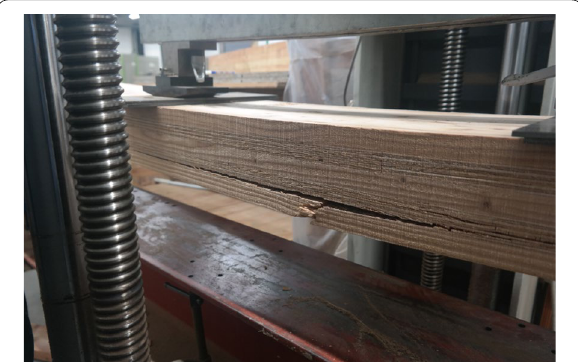
Fig. 5 Failure modes specimen of bending test (span‑to‑depth